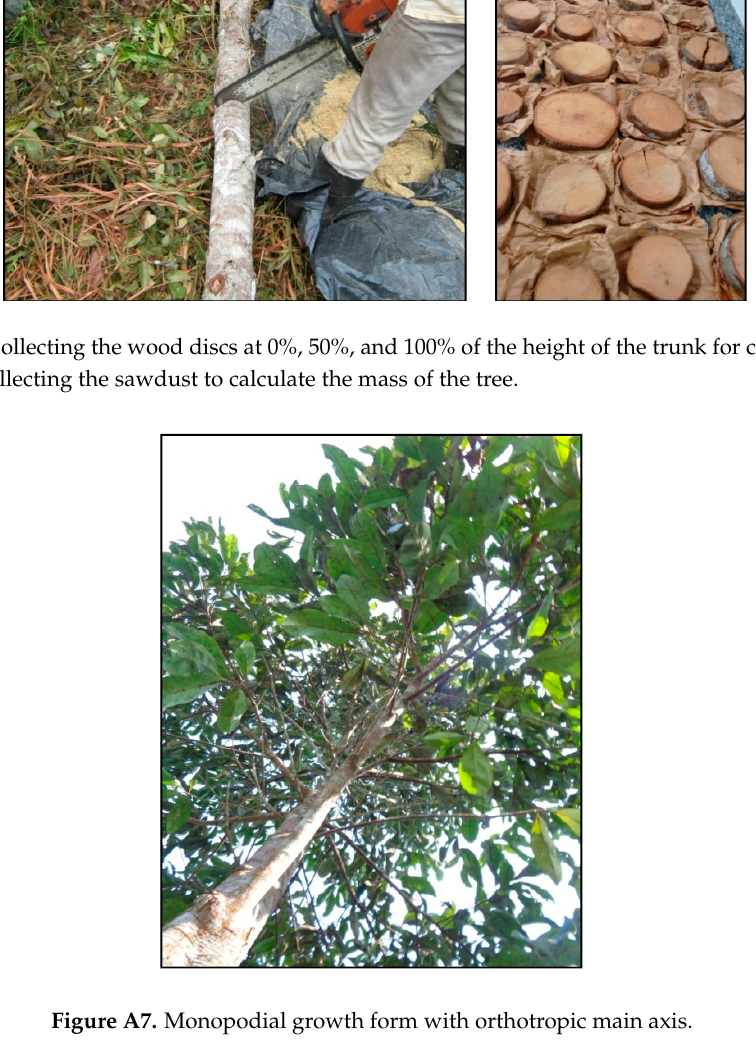
Figure A7. Monopodial growth form with orthotropic main axis.